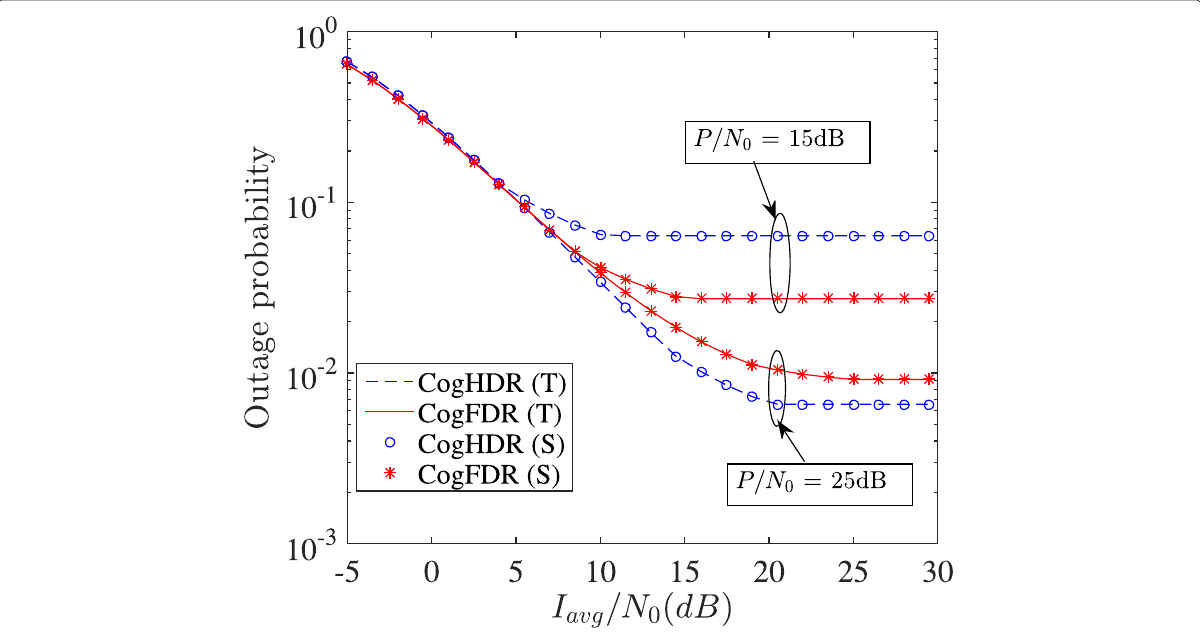
Fig. 4 Outage probability vs. I avg / N 0 for P / N 0 = 15 dB and 25